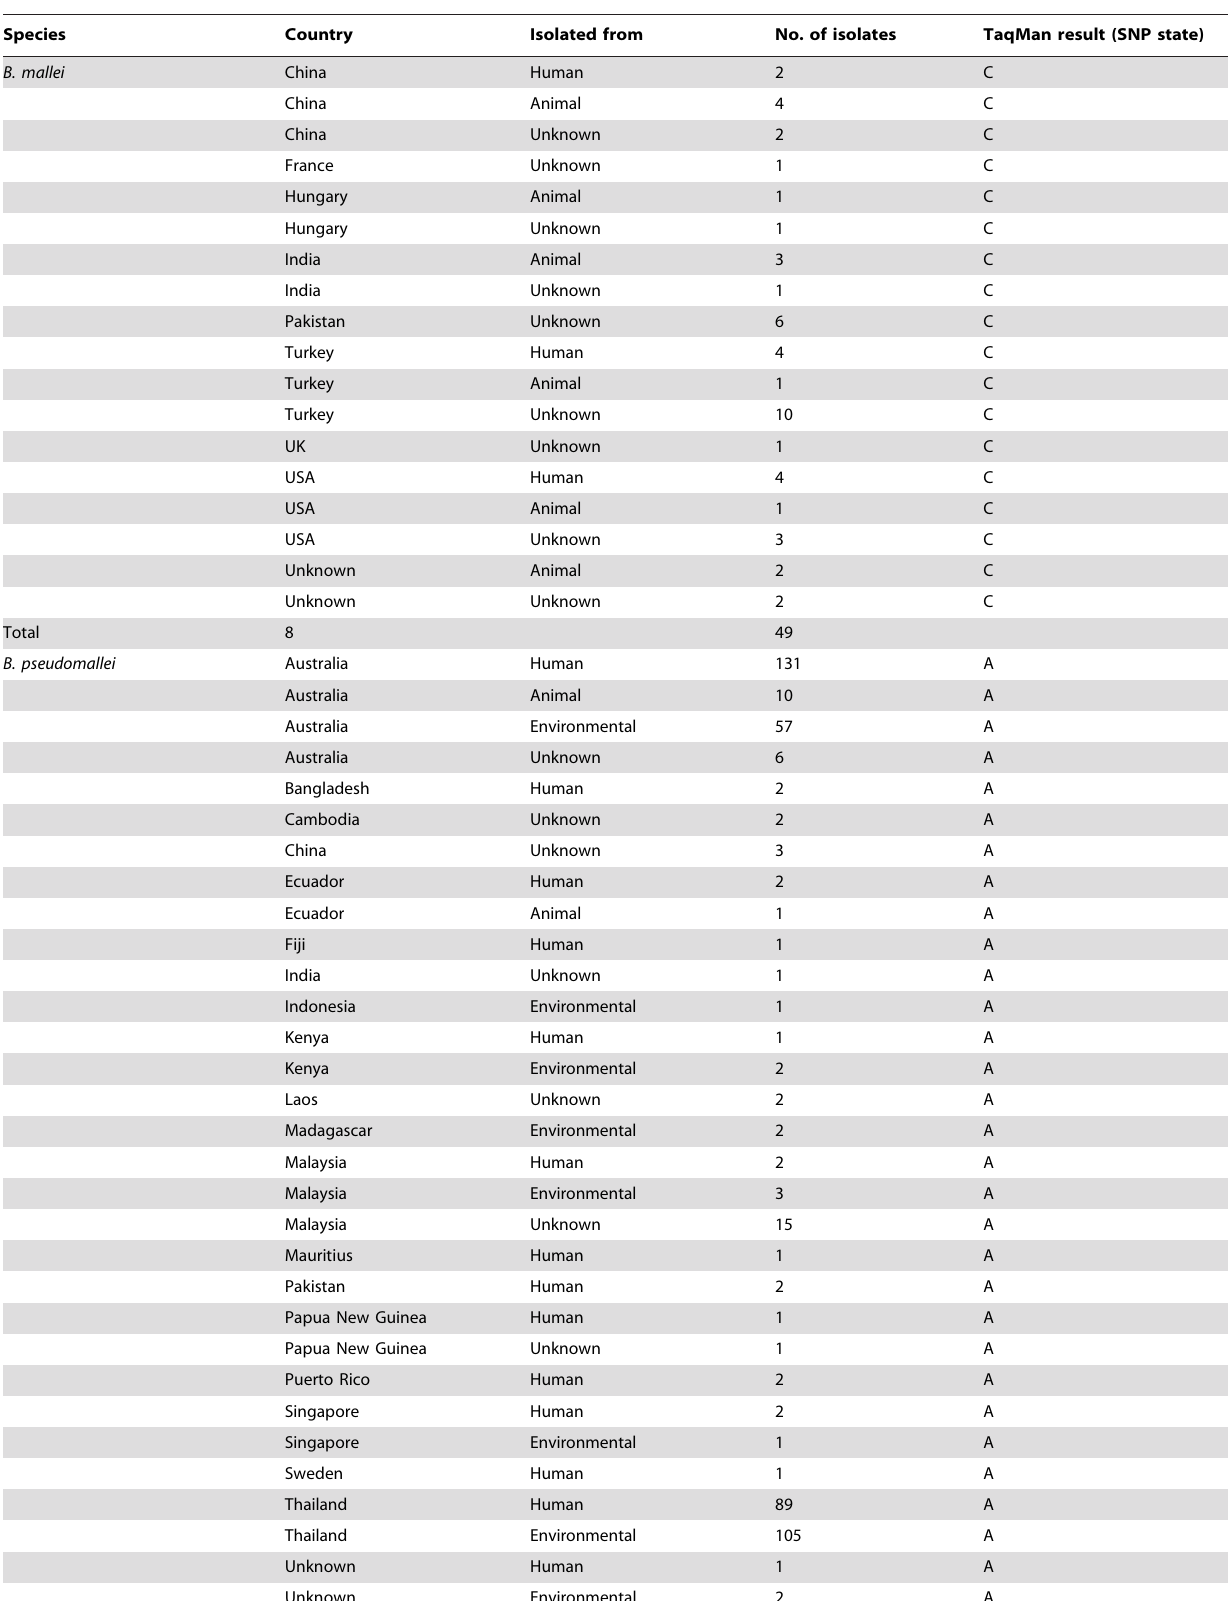
Table 1. Number and origin of B. pseudomallei , B. mallei , and genetic near-neighbor strains used in this study.